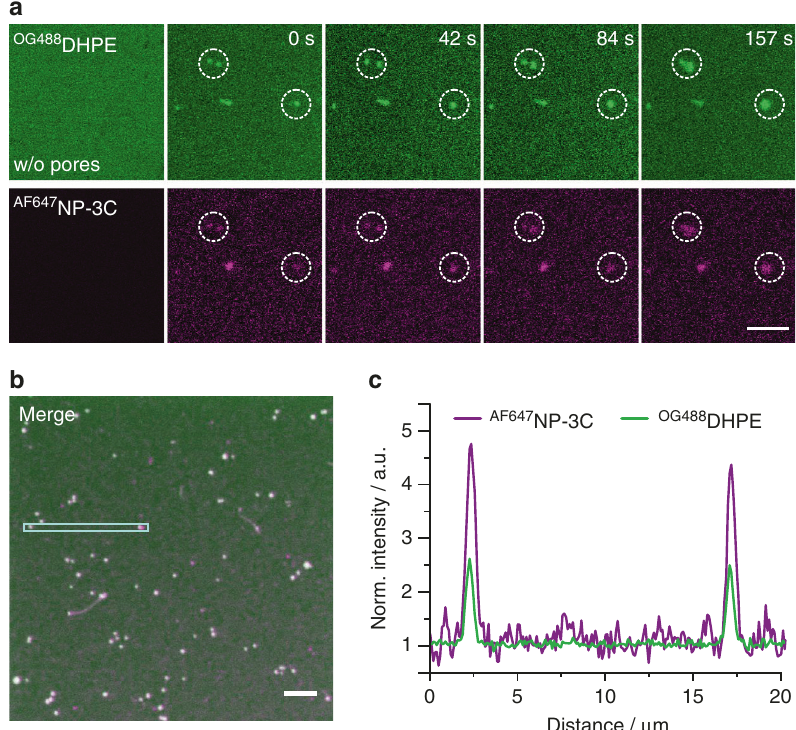
Fig. 5 Membrane remodeling by NP-3C. a Time-lapse confocal fl uorescence imaging of AF647 NP-3C (magenta) bound to membrane protrusions from a PSM that was doped with the lipid marker Oregon Green 488 1,2-dihexadecanoyl-sn-glycero-3-phosphoethanolamine ( OG488 DHPE (- green). The fi rst column shows a representative area before the addition of AF647 NP-3C. Scale bar: 5 µ m. b Overlay image of AF647 NP-3C (magenta) bound to the PSM stained with OG488 DHPE (green). Scale bar: 5 µ m. c Fluorescence intensity pro fi le across two representative membrane protrusions highlighted in panel b . Both fl uorescence channels were normalized to the basal fl uorescence levels within the planar